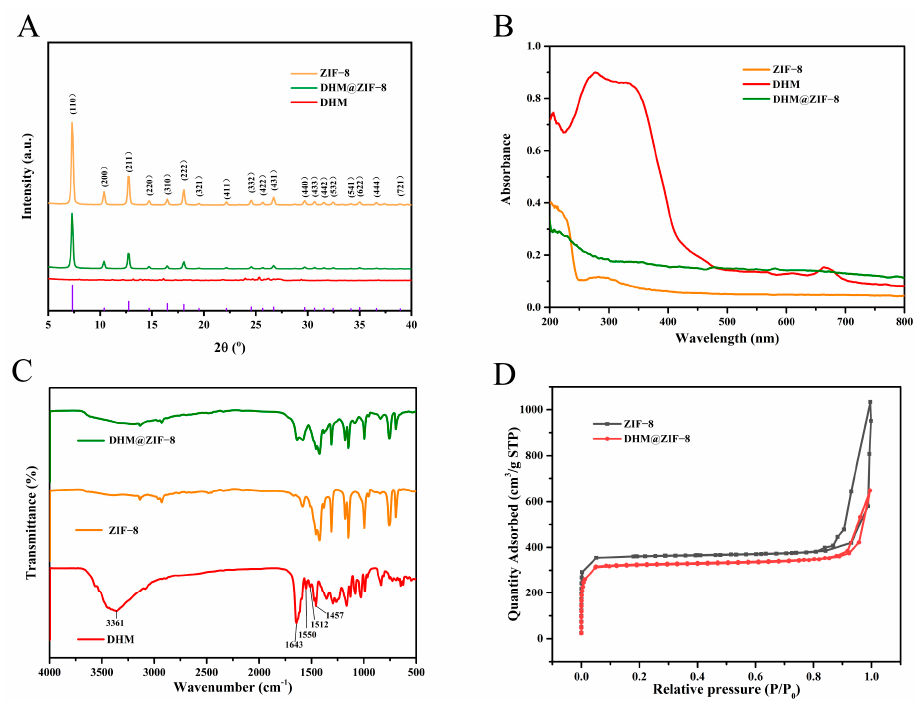
Figure 2. ( A ) XRD maps of ZIF-8, DHM and DHM@ZIF-8. ( B ) UV absorption profiles of ZIF-8, DHM, and DHM@ZIF-8. ( C ) IR spectra of ZIF-8, DHM, and DHM@ZIF-8. ( D ) N 2 adsorption-desorption isotherms of ZIF-8 and DHM@ZIF-8.